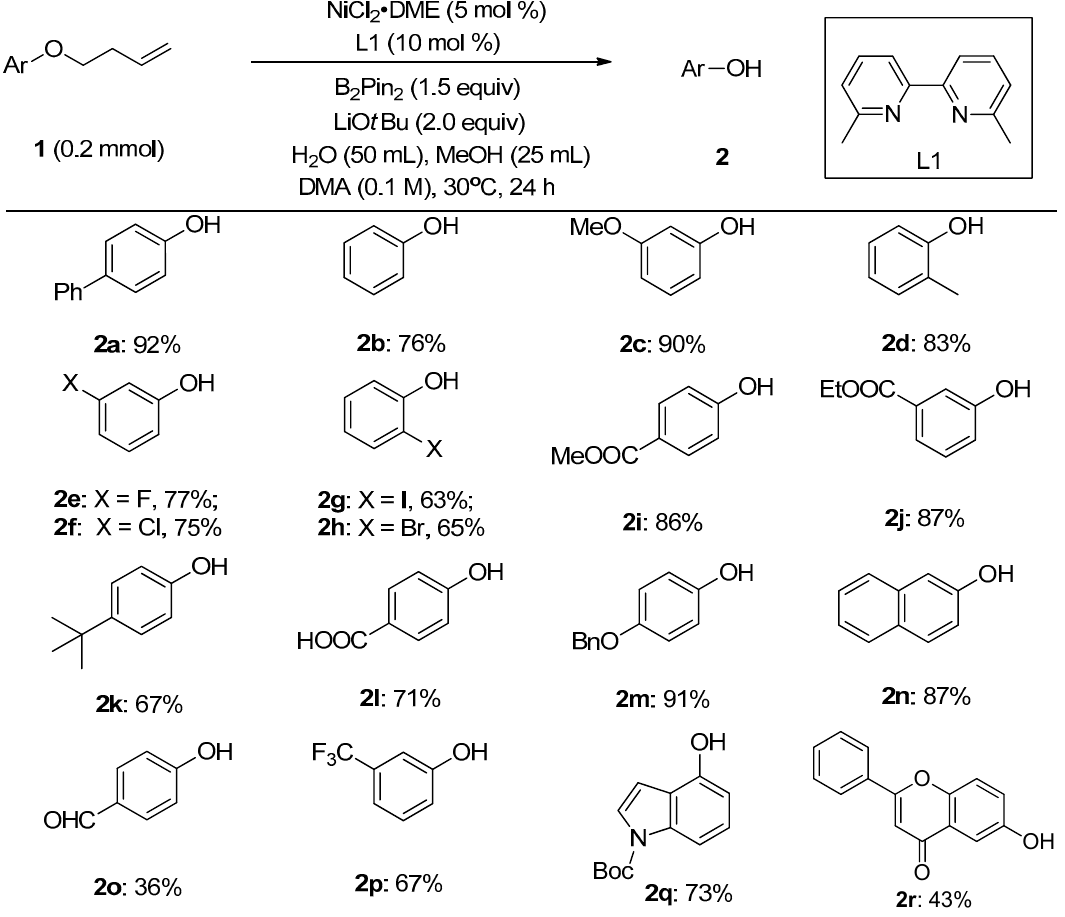
Table 2. Scope of phenol. Conditions: See Supplementary Materials for details.